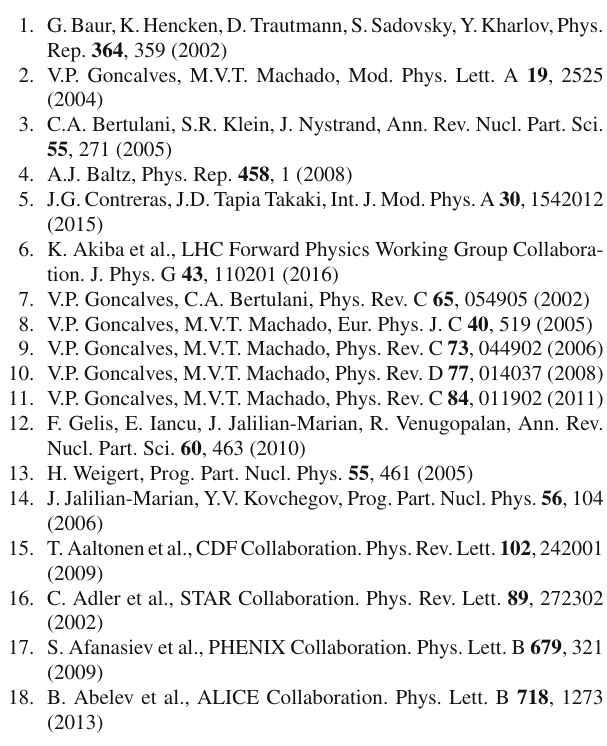
Fig. 4 Rapidity distributions for the exclusive vector meson photoproduction in pAr and PbAr collisions at